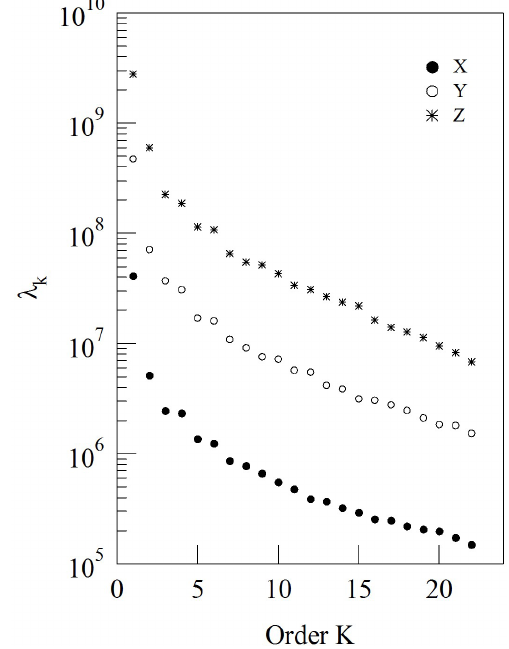
Fig. 1. The NOC eigenvalue spectra λ k of X , Y and Z magnetic field components recorded at Mario Zucchelli Station (TNB) in Antarctica. The λ k spectra of Y and Z components have been scaled by a factor of 10 and 10 2 , respectively, for